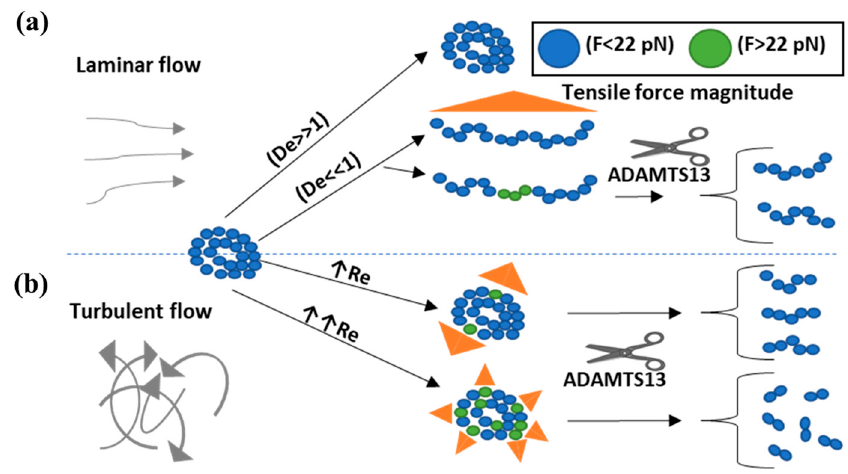
Figure 4. Hypothetical drawing of the VWF stretch and cleavage in ( a ) laminar flow ( b ) turbulent flow.